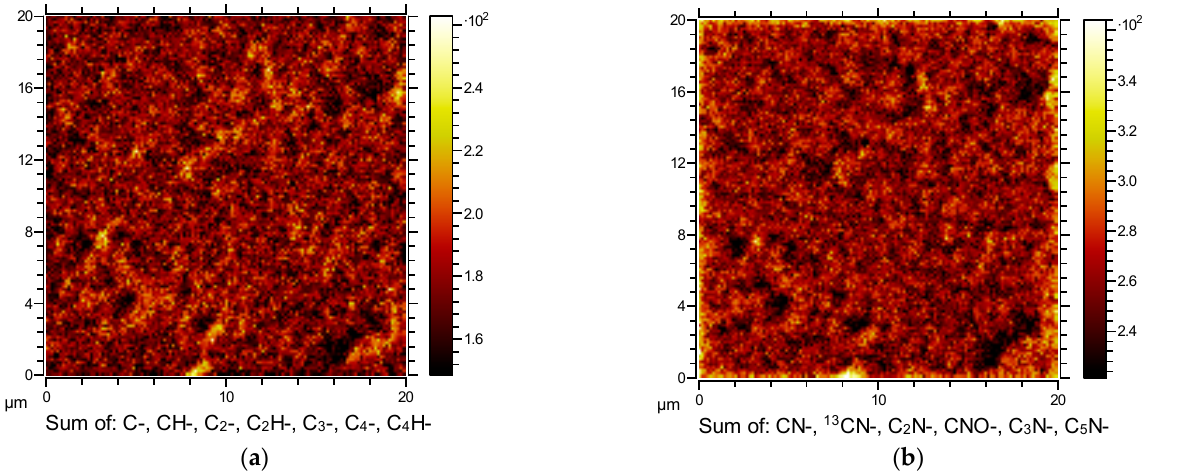
Figure 12. 2D SIMS image of N-doped carbon nanomesh surface: ( a ) distribution of carbon fragments, and ( b ) distribution of nitrogen-containing fragments. The deposition time was 60 s.